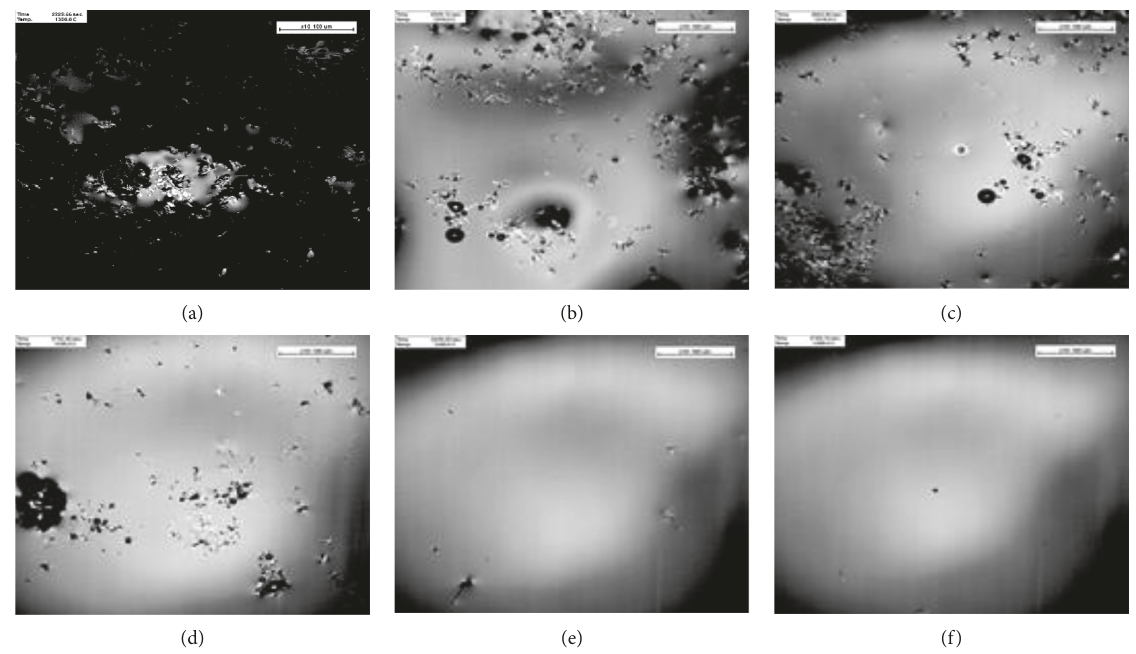
Figure 3: The evolution rules of morphology without B